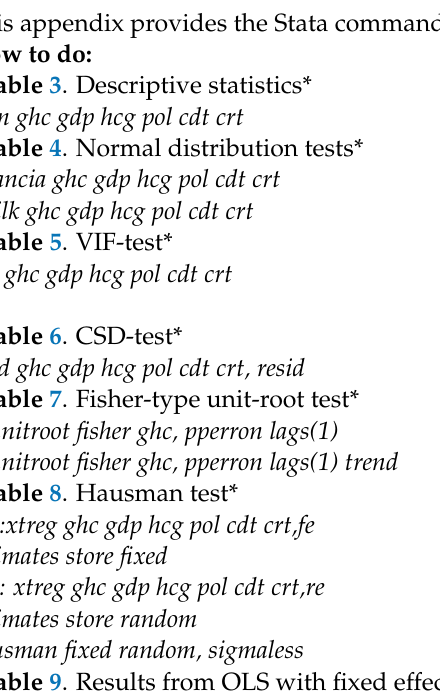
* Table 7 . Fisher-type unit-root